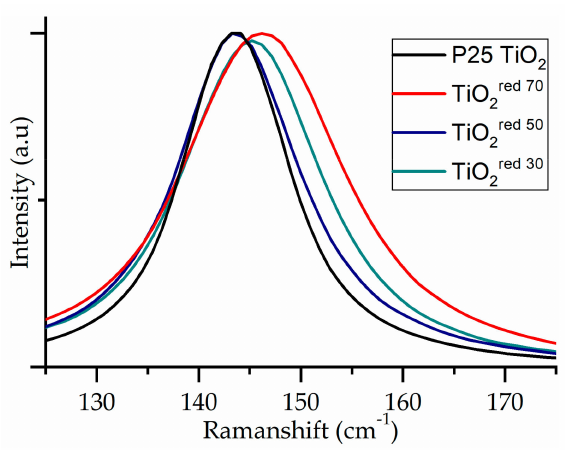
Figure 5. Raman spectrum of P25 TiO 2 series showing shift toward the visible region as a function of reductive treatment